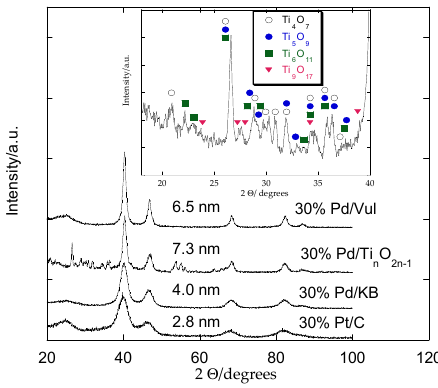
Figure 1. XRD patterns of 30% Pd/Vul, 30% Pd/KB, 30% Pd/Ti n O 2 n –1 and commercial 30% Pt/C. Inset: Ti-oxide phases for Pd/Ti n O 2 n –1 catalyst.